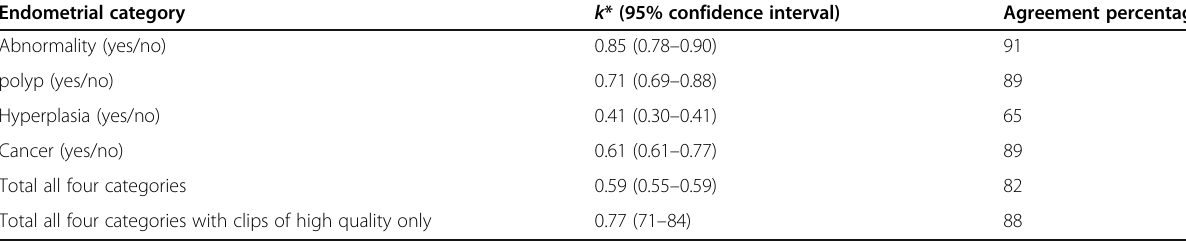
Table 3 Cohen ’ s kappa coefficient for inter-observer agreement at offline analysis Endometrial category k * (95% confidence interval)